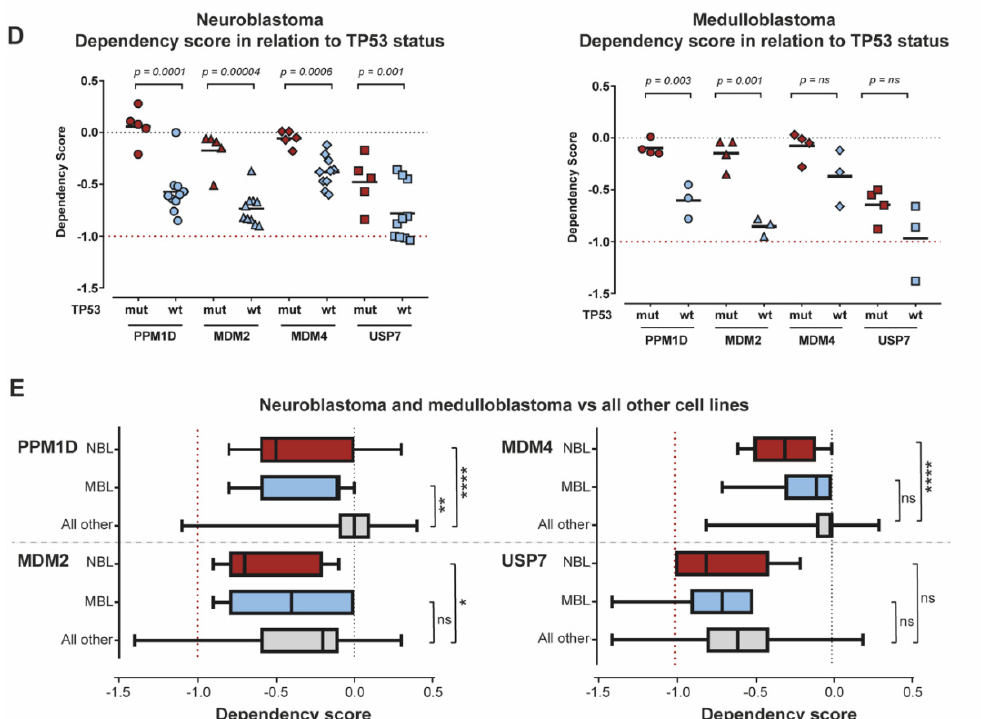
Figure 2. PPM1D expression is important for neuroblastoma and medulloblastoma survival. ( A ) Genome-scale CRISPR- Cas9 screening showing ranked average difference in genetic dependencies between wild-type TP53 and mutated TP53 neuroblastoma and medulloblastoma cell lines. ( B ) Dependency score showing high PPM1D dependency in wild-type TP53 neuroblastoma and medulloblastoma cells. Wild-type TP53 cell lines (blue, high dependency) and TP53 -mutated cell lines (red, low dependency) with TP53 status. ( C ) STRING database analysis showing PPM1D dependency in wild-type TP53 neuroblastoma and medulloblastoma cells. Among the top 40 genes with the largest differences in gene dependency, as expressed as CERES scores, there was an enrichment of genes involved in the negative regulation of cell proliferation (indicated in blue), cell cycle process (red), cellular response to DNA damage (yellow) and chromosome organization (green). The width of the edges corresponds to the level of confidence (medium confidence STRING scores of 0.4; high confidence STRING score 0.7; and highest confidence STRING score 0.9). ( D ) Wild-type TP53 neuroblastoma and medulloblastoma cells are highly dependent on PPM1D expression for survival. Genome-scale CRISPR-Cas9 screening showing ranked average differences in genetic dependencies between wild-type vs. TP53 -mutated cell lines. ( E ) Dependency scores of PPM1D , MDM2 , MDM4 , and USP7 in relation to TP53 mutational status in neuroblastoma and medulloblastoma cell lines. For PPM1D , there was a statistically significantly stronger genetic dependency in neuroblastoma and medulloblastoma cells as compared with all other cell lines. * p < 0.05, ** p < 0.01, **** p <